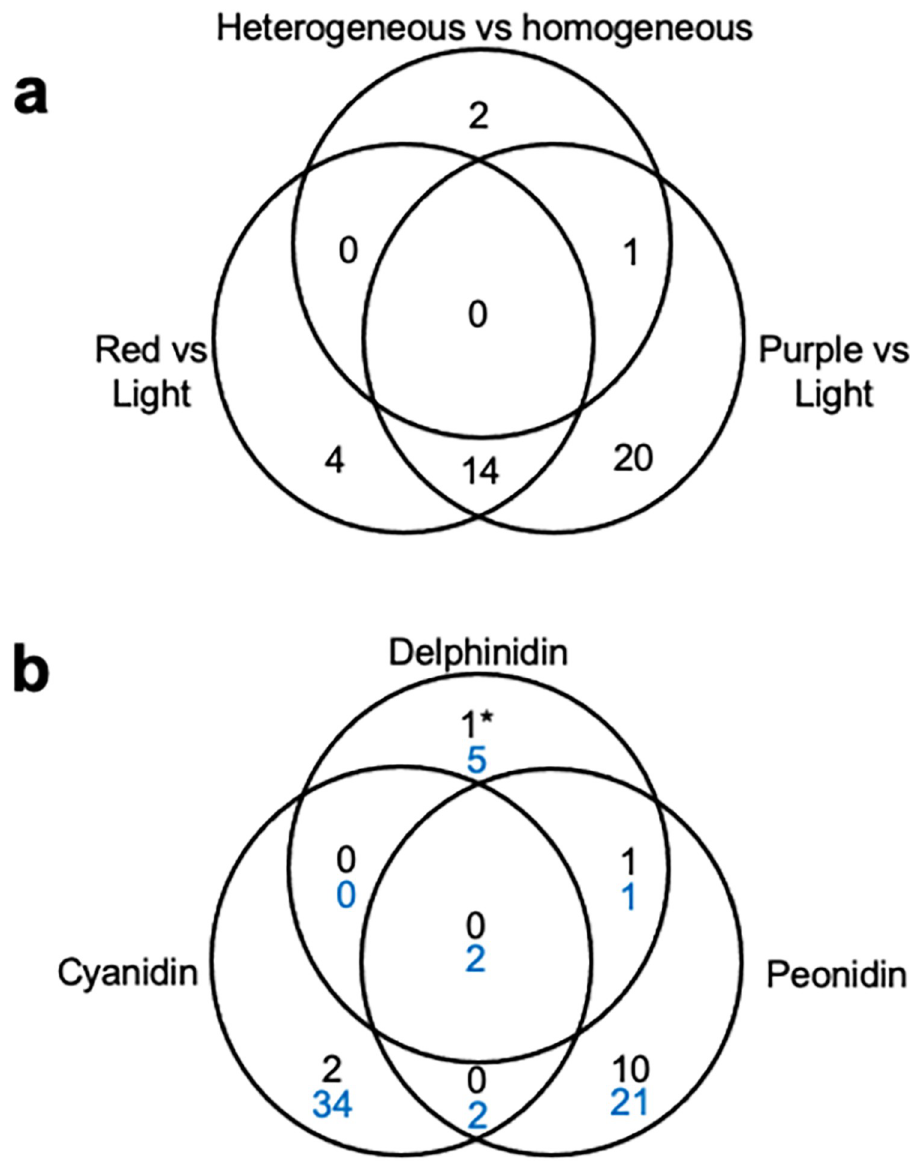
Fig 3. Number of genes expressed differentially between accessions with different colorations and anthocyanin contents. ( a ) Venn Diagram showing the number of differentially expressed genes (DEGs) in three comparisons between potatoes with different colorations: purple vs light, red vs light, homogeneous vs heterogeneous. ( b ) Venn Diagram showing the number of genes showing correlations between expression and the content of three anthocyanins (ExM genes): Cyanidin, delphinidin, and peonidin. The number of genes with positive correlations to anthocyanin content is shown in black; the number of genes showing negative correlations to anthocyanin content is shown in blue. The DFR gene, which is marginally associated to delphinidin is indicated with ( � ).